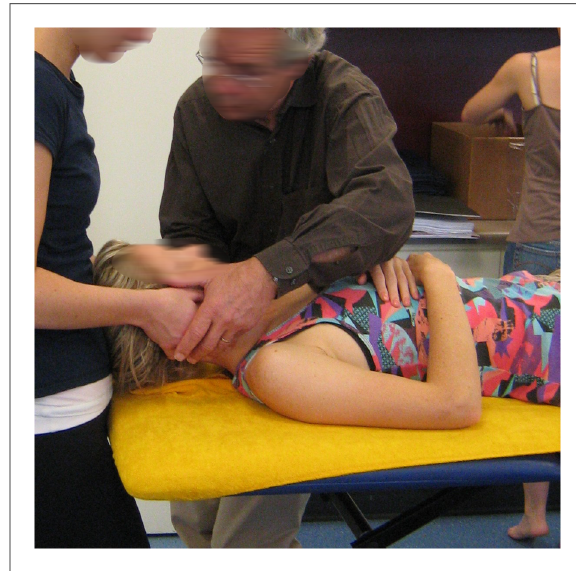
FIGURE 1 Examples of an instructor aiding learning of embodied enaction. Image at right courtesy of Dr. Steve